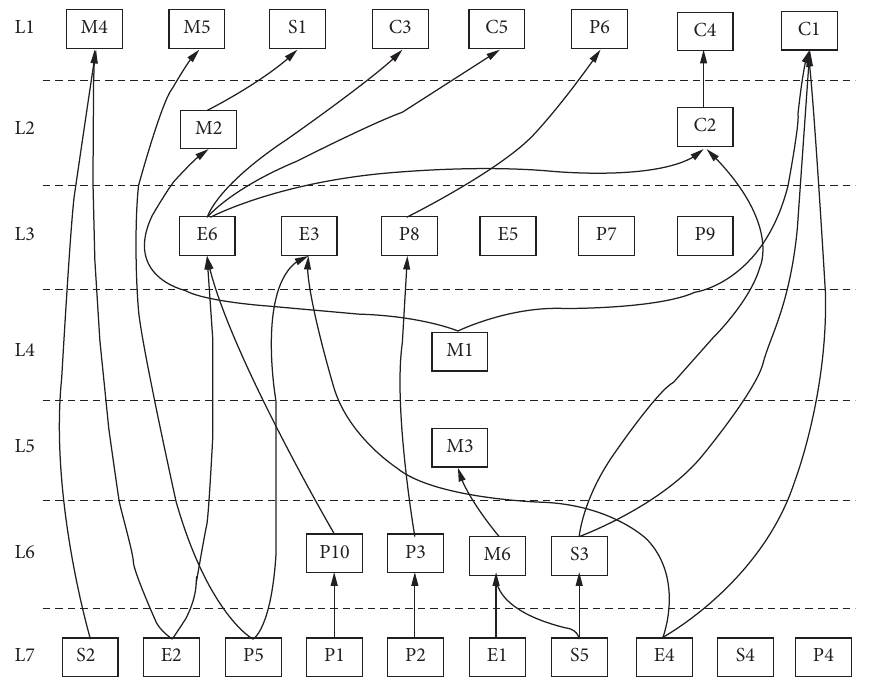
Figure 2: The multilevel hierarchical model of causal factors regarding metro-operation